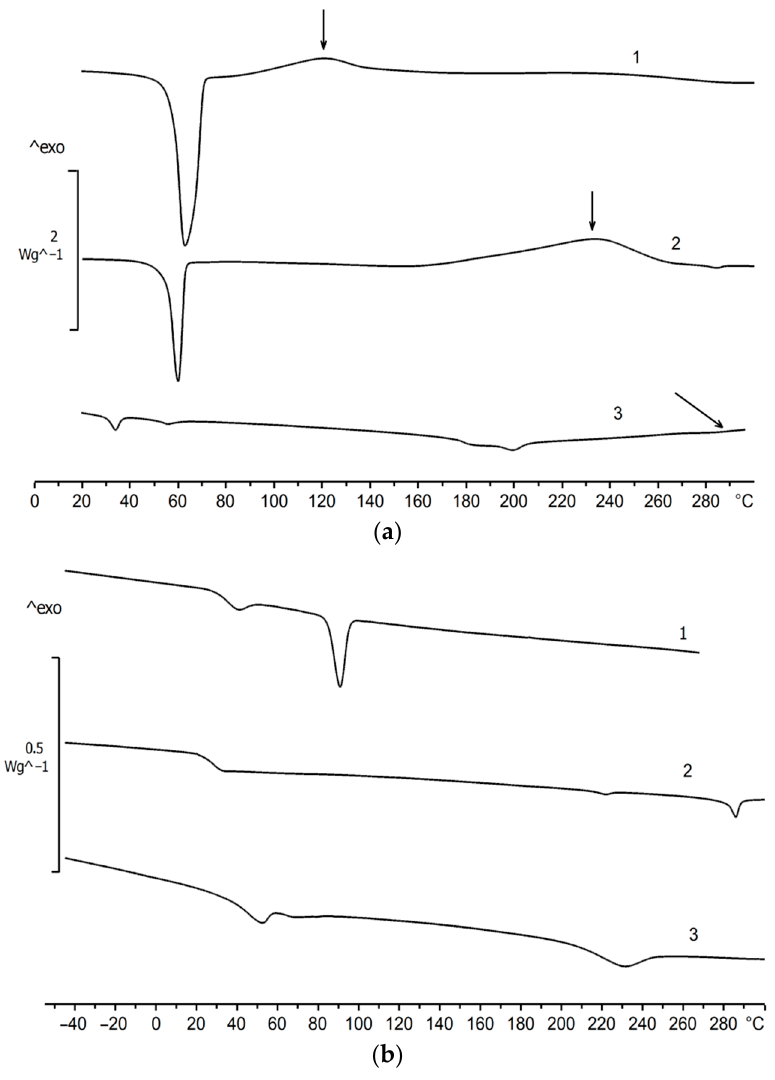
Figure 6. DSC curves of vinyl ketones: ( a ) BVK (1), TVK (2), and QVK (3) and ( b ): poly(vinyl ketones) BVK (1), TVK (2), and QVK (3). Heating rate 10 K·min − 1 .